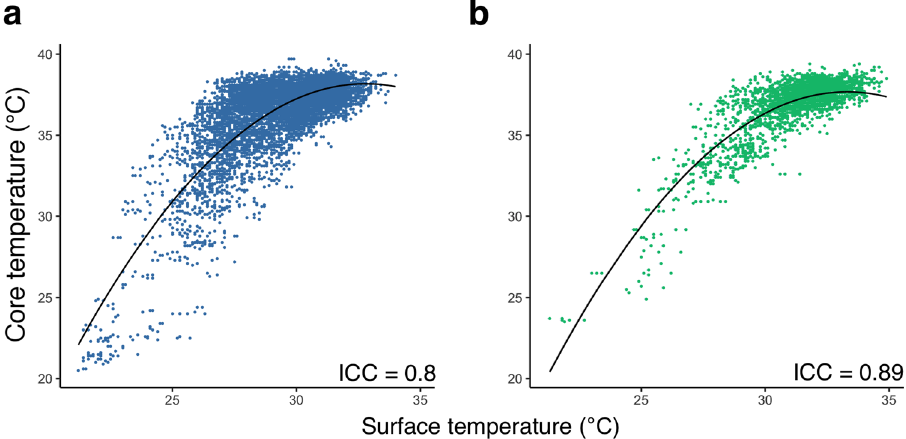
Figure 3. Prediction of core temperature from surface temperature using a mixed effects model. ( a ) Surface temperature measured by thermometer 2, plotted against the corresponding core temperature (n = 124, ICC = 0.80 (95%CI: 0.79–0.81)) and ( b ) surface temperature measured by thermometer model 1, plotted against the corresponding core temperature (n = 53, ICC = 0.89 (95%CI: 0.88–0.90)) show a positive non-linear correlation. A fitted mixed effects model was used to predict the corresponding core temperature from surface temperature. Marginal R2 (R2m): 0.65, conditional R2 (R2c): 0.81; Black solid line, fit line of the mixed effects model showing the core temperature predicted from surface temperatur. = −